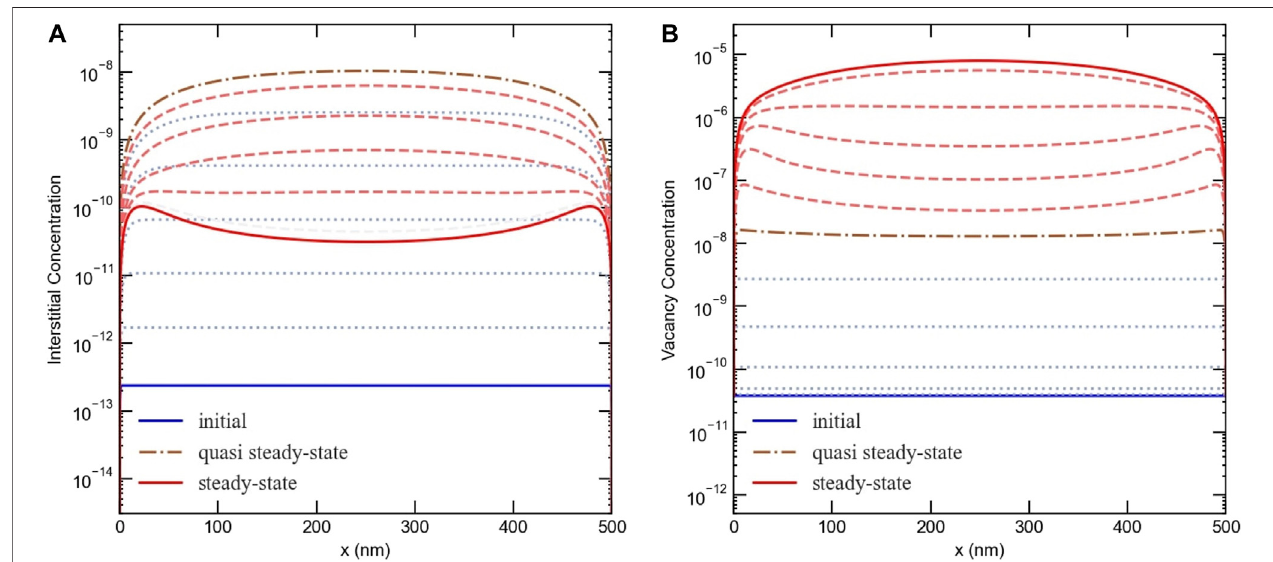
FIGURE3| Theevolutionofdefectconcentrationpro fi lesat1e-3 dpa/sand5%productionbiasina500 nmslab/equiaxedgrain (A) planargeometrywithtwofree surfaces/boundaries at bothends), (A) forinterstitials, (B) forvacancies.Thecalculatedtimes are1.5764e-3 sforquasi-steadystateconditionand88.8253 sforsteady state condition ( Figure 2B